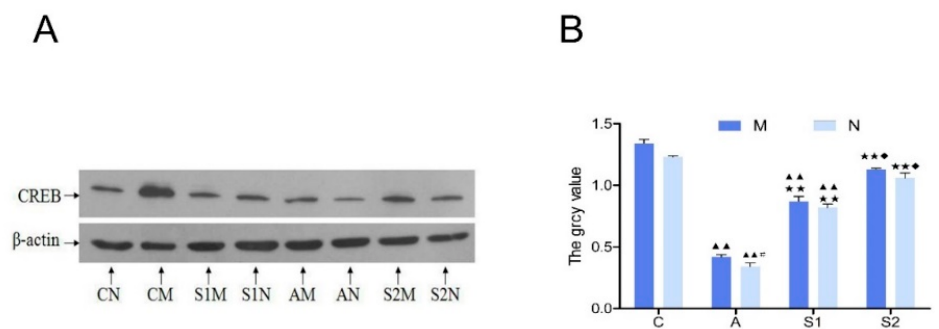
Figure 6. ( A ): Western blotting analysis for determining CREB protein expression levels in rat hippocampus. ( B ): Densitometric quantification of CREB protein expression (Mean ± SD; n = 10/group). The in-graph symbols indicate: ▲▲ p < 0.01 versus Group C ; * p < 0.05 or ** p < 0.01 versus Group A ; (cid:7) p < 0.05 versus group S1 ; # p < 0.05 versus Group M .